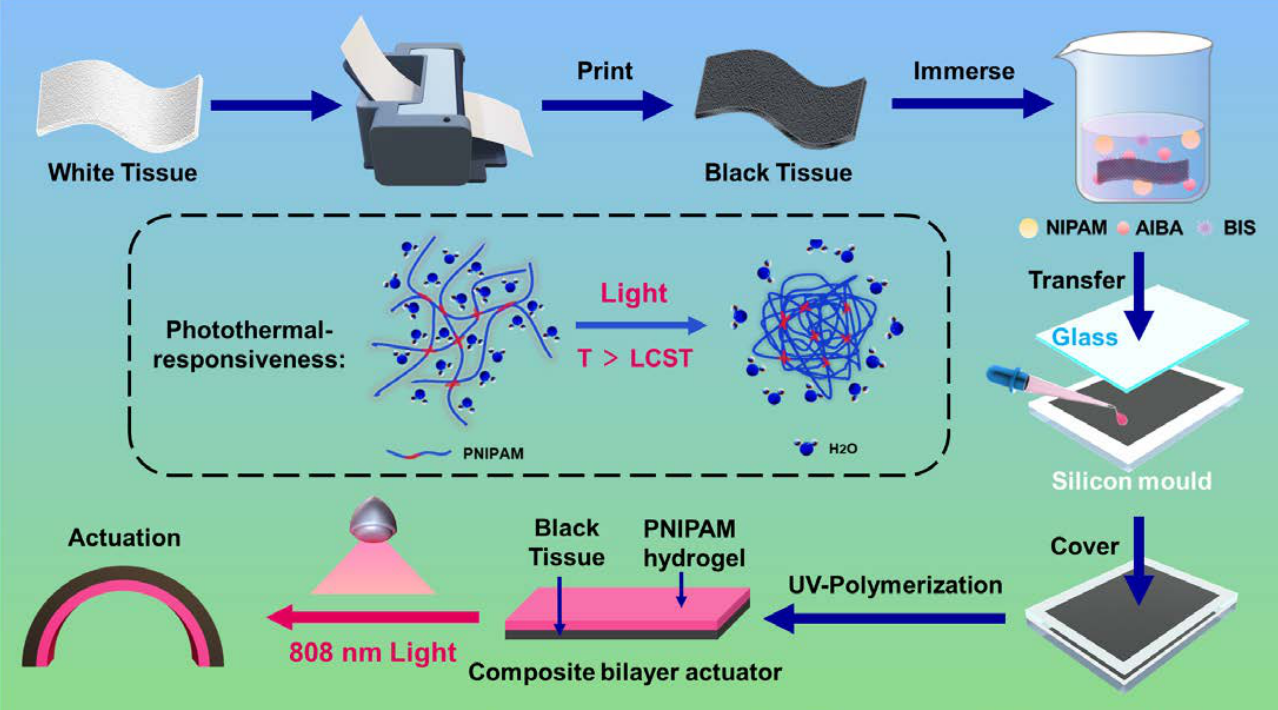
Figure 1. Illustration on fabrication and remotely controlled light-responsive actuation of the tissue paper/PNIPAM hydrogel composite actuator.